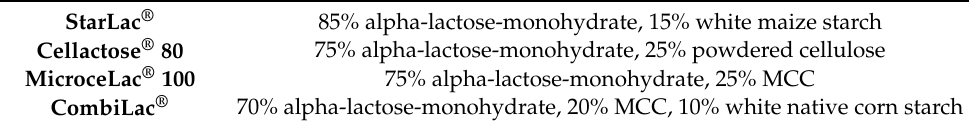
Table 1. Composition of